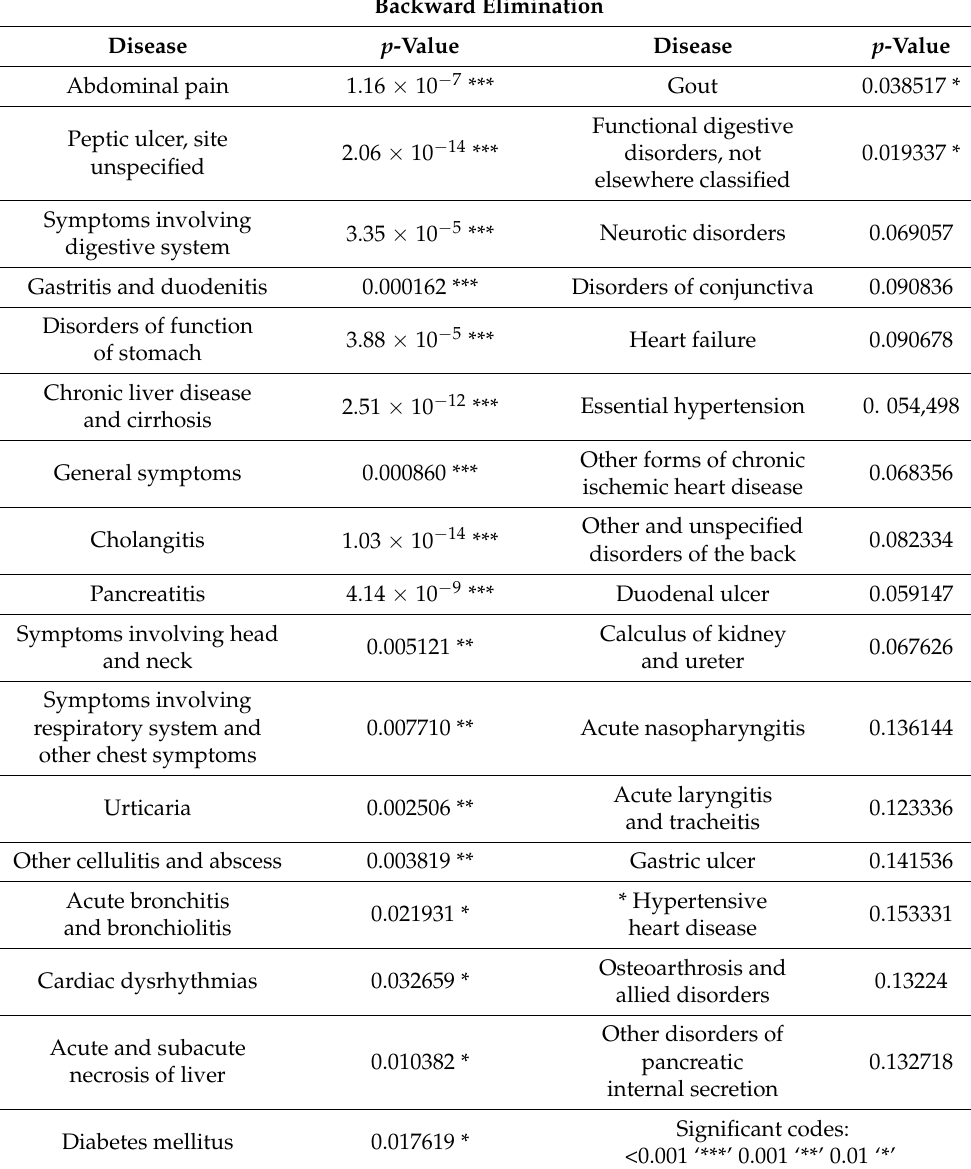
Table 2. The results of stepwise